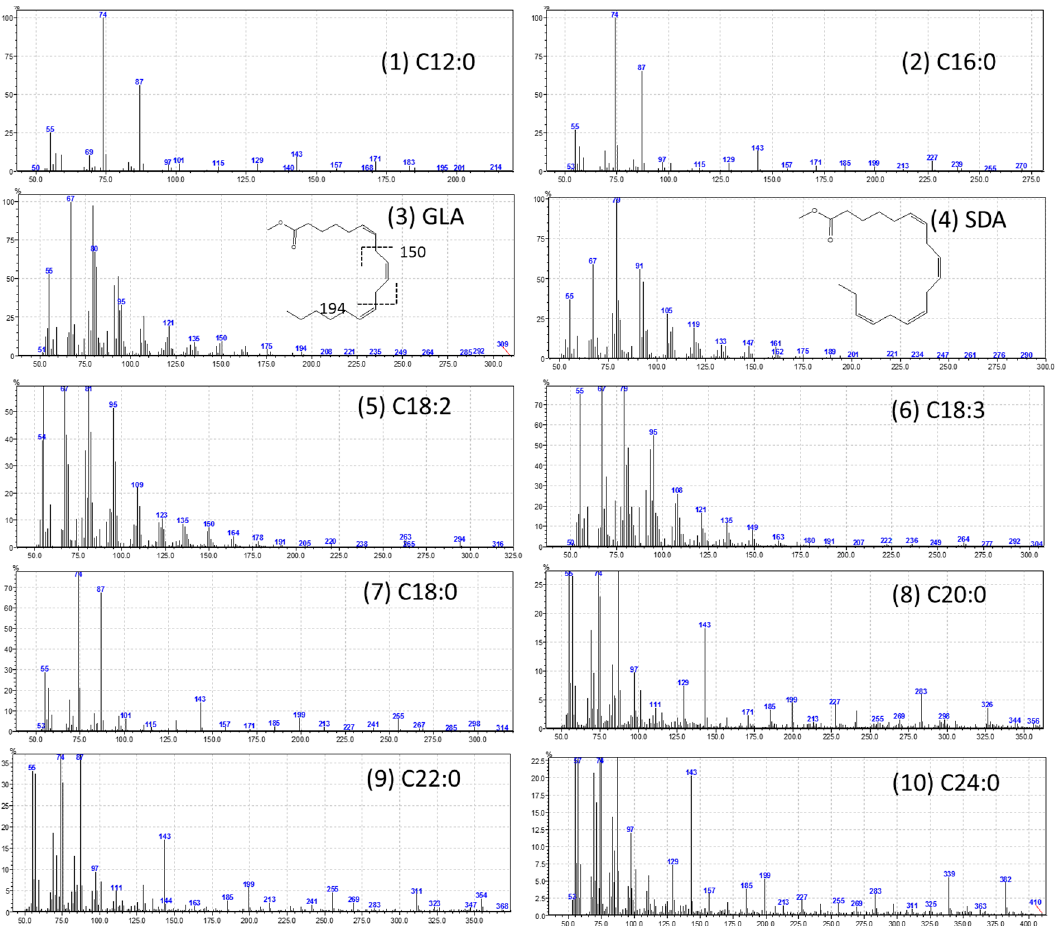
Figure 5. Mass spectra of fatty acid methyl esters (FAMEs). ( 1 ) C12:0 (lauric acid); ( 2 ) C16:0 (palmitic acid); ( 3 ) C18:3n6 ( γ -linolenic acid); ( 4 ) C18:4n3 (stearidonic acid); ( 5 ) C18:2n6c (linoleic acid); ( 6 ) C18:3n3 ( α -linolenic acid); ( 7 ) C18:0 (stearic acid); ( 8 ) C20:0 (arachidic acid); ( 9 ) C22:0 (behenic acid); and ( 10 ) C24:0 (lignoceric acid).